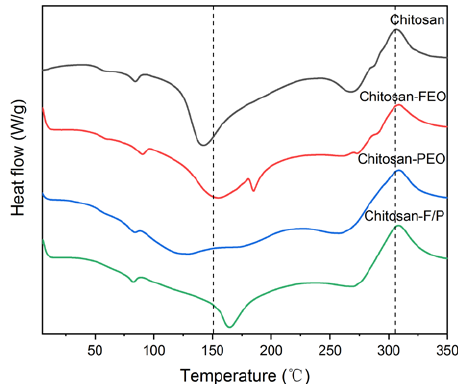
Figure 2. DSC spectra of Chitosan, Chitosan-FEO, Chitosan-PEO, and Chitosan-F/P films.